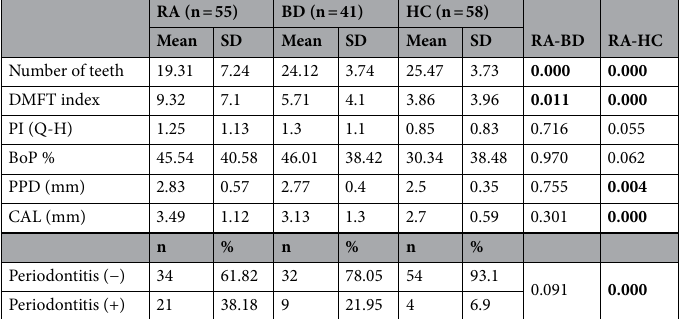
Table 2. Overview of oral health parameters recorded in the study cohort. On the right side of the table, the two last columns display p values from pair of groups comparisons (Mann–Whitney, p = 0.05). Significant p values are bolded. RA rheumatoid arthritis, BD Behçet’s disease, HC healthy control, DMFT decayed, missing and filled teeth index, PI (Q–H) plaque index (Quigley–Hein), BoP bleeding on probing, PPD probed pocket depth, CAL clinical attachment loss.